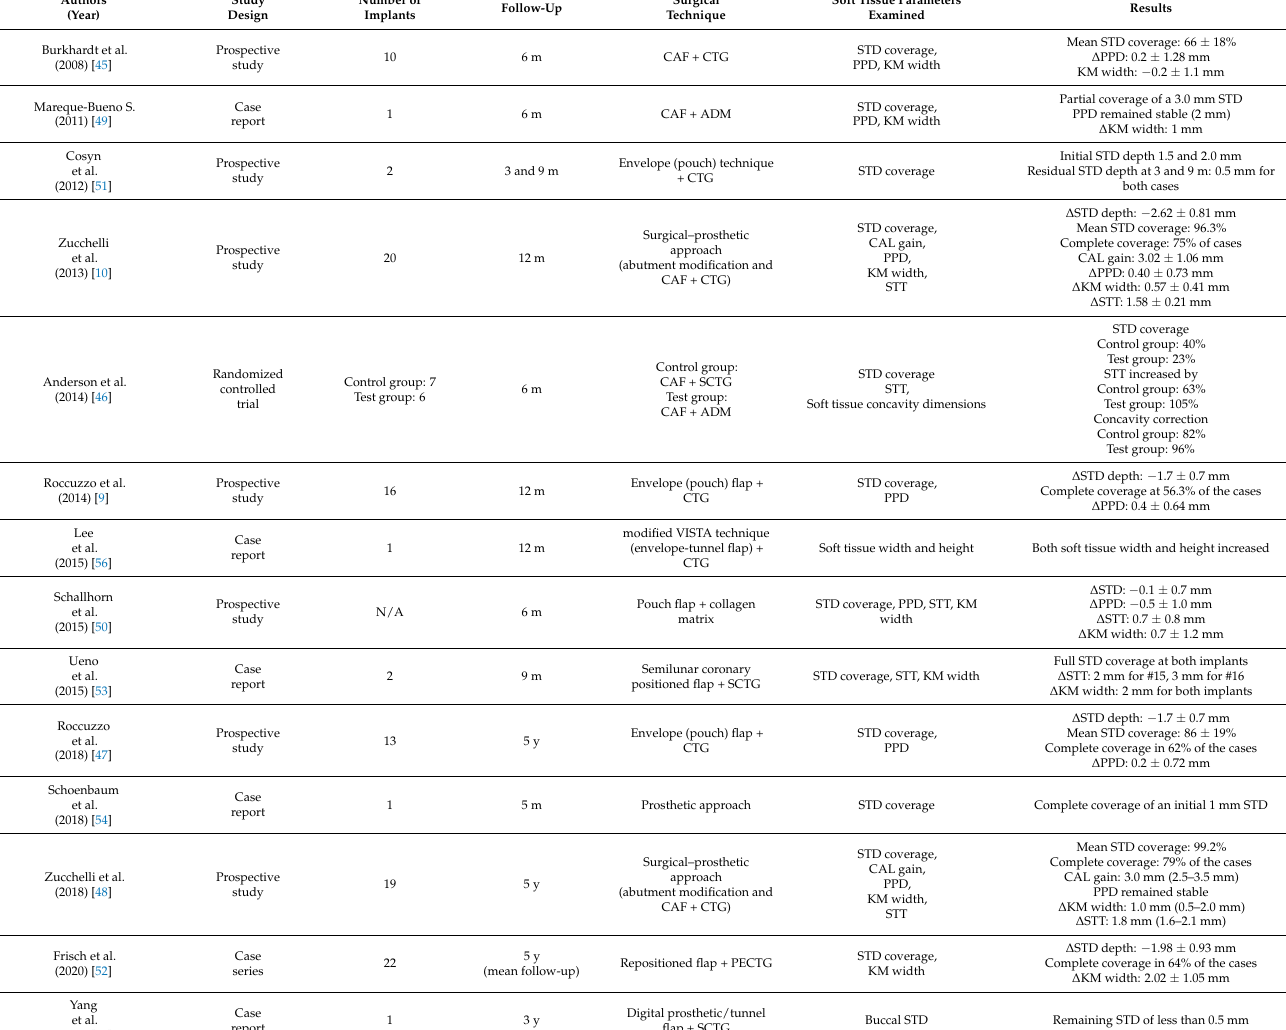
Table 1. Surgical techniques for the treatment of PSTD and clinical